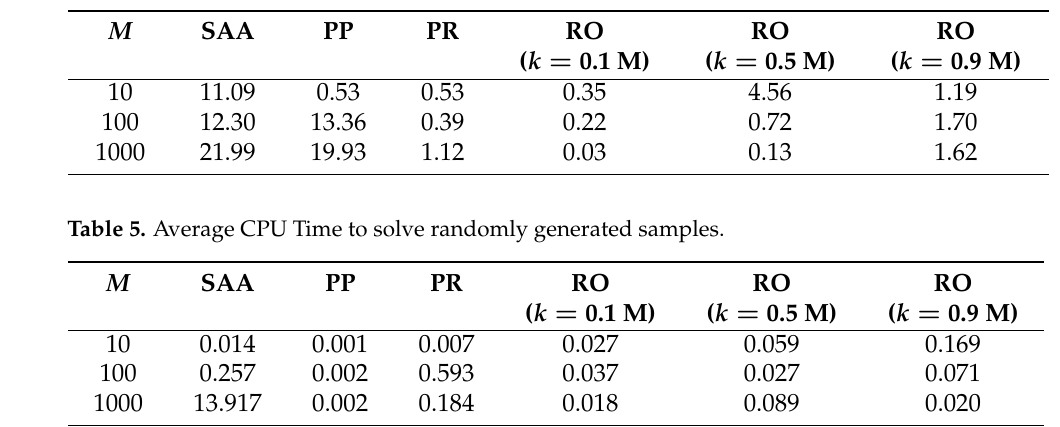
Table 4. Average out-of-sample performance for randomly generated samples.